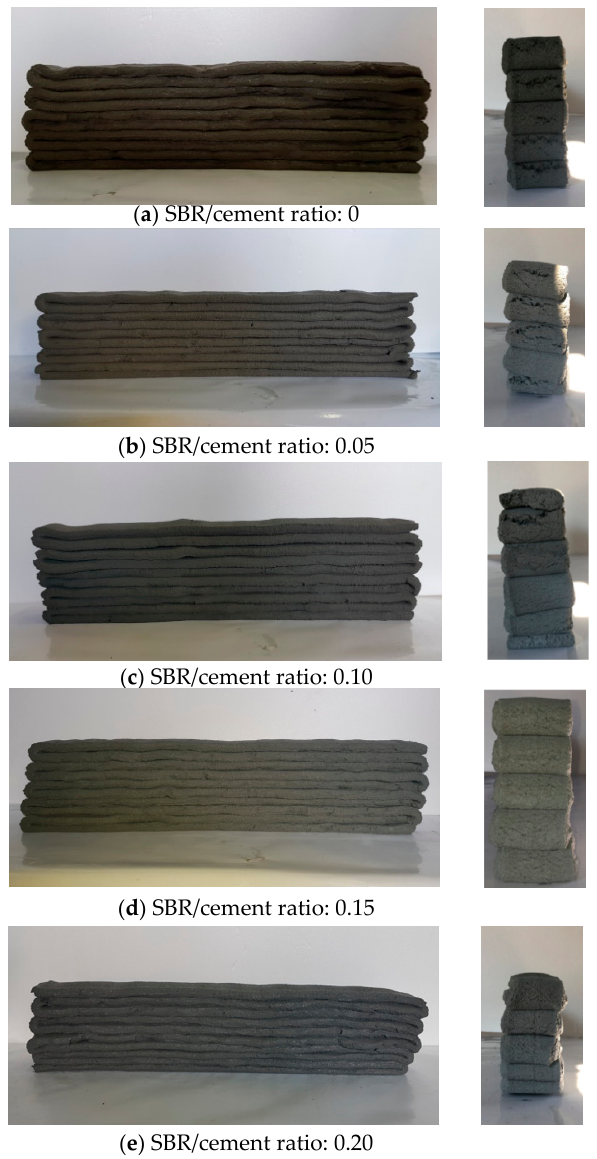
Figure 9. Test results for buildability (flow: 70%).